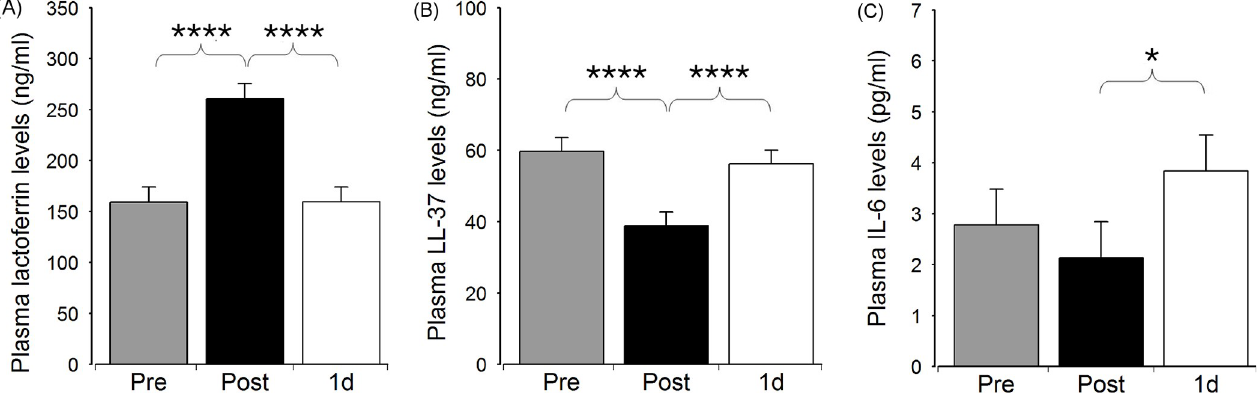
Fig 1. Plasma levels of the soluble inflammatory markers directly before (Pre), directly after stenting (Post), and on the next day following PCI (1d). Data are presented as mean ± SE, n = 23. Significant differences for lactoferrin and LL-37: Pre/Post, Post/1d - p ���� < 0.0001; for IL-6: Post/1d - p � < 0.05.